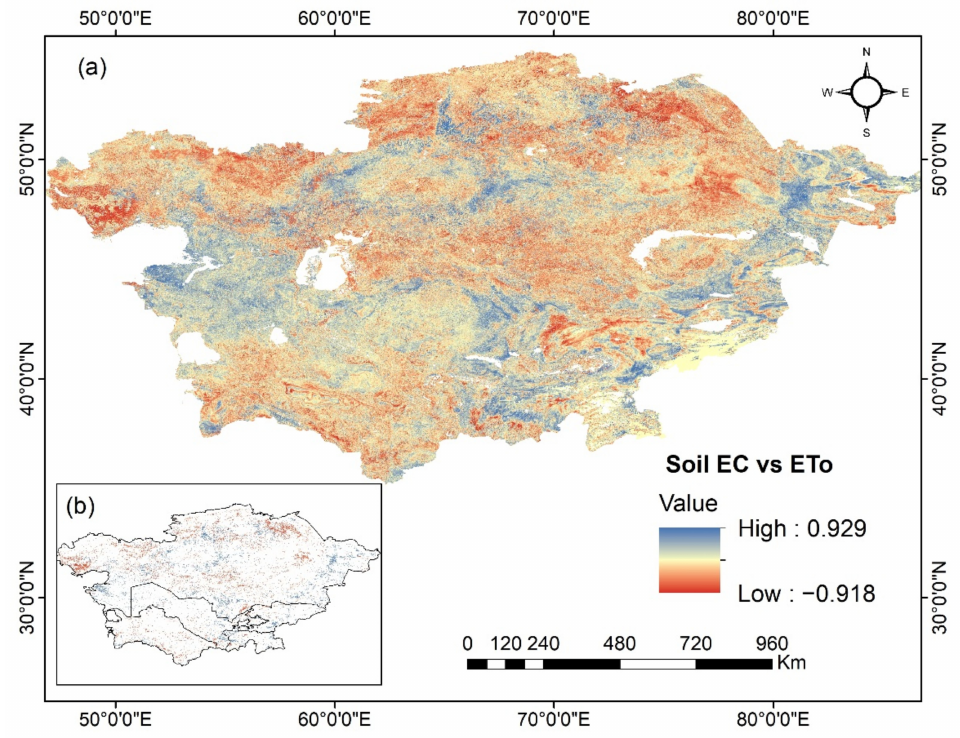
Figure 7. ( a ) Soil EC correlation to evapotranspiration, and ( b ) significant changes during 2000–2018.